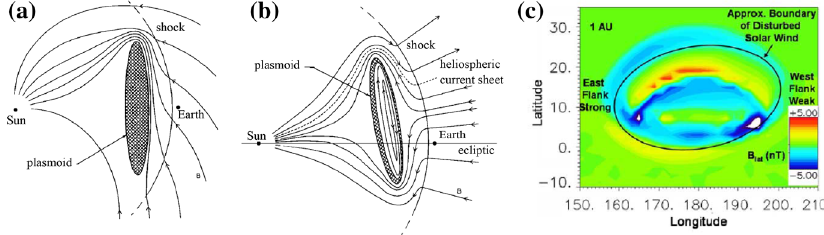
Fig. 20 Draping of the IMF around the ICME. Sketch of the draping of the IMF around and ICME in a the ecliptic plane and b the meridional plane. c Global MHD simulation results of a Parker spiral type IMF draping. The strength of the out-of-ecliptic IMF component is shown for a view towards the Sun (ignore the part within the oval that belongs to ICME). Panels ( a ) and ( b ) reproduced by permission from Gosling and McComas (1987); Panel ( c ) from Siscoe et al. (2007), copyright by